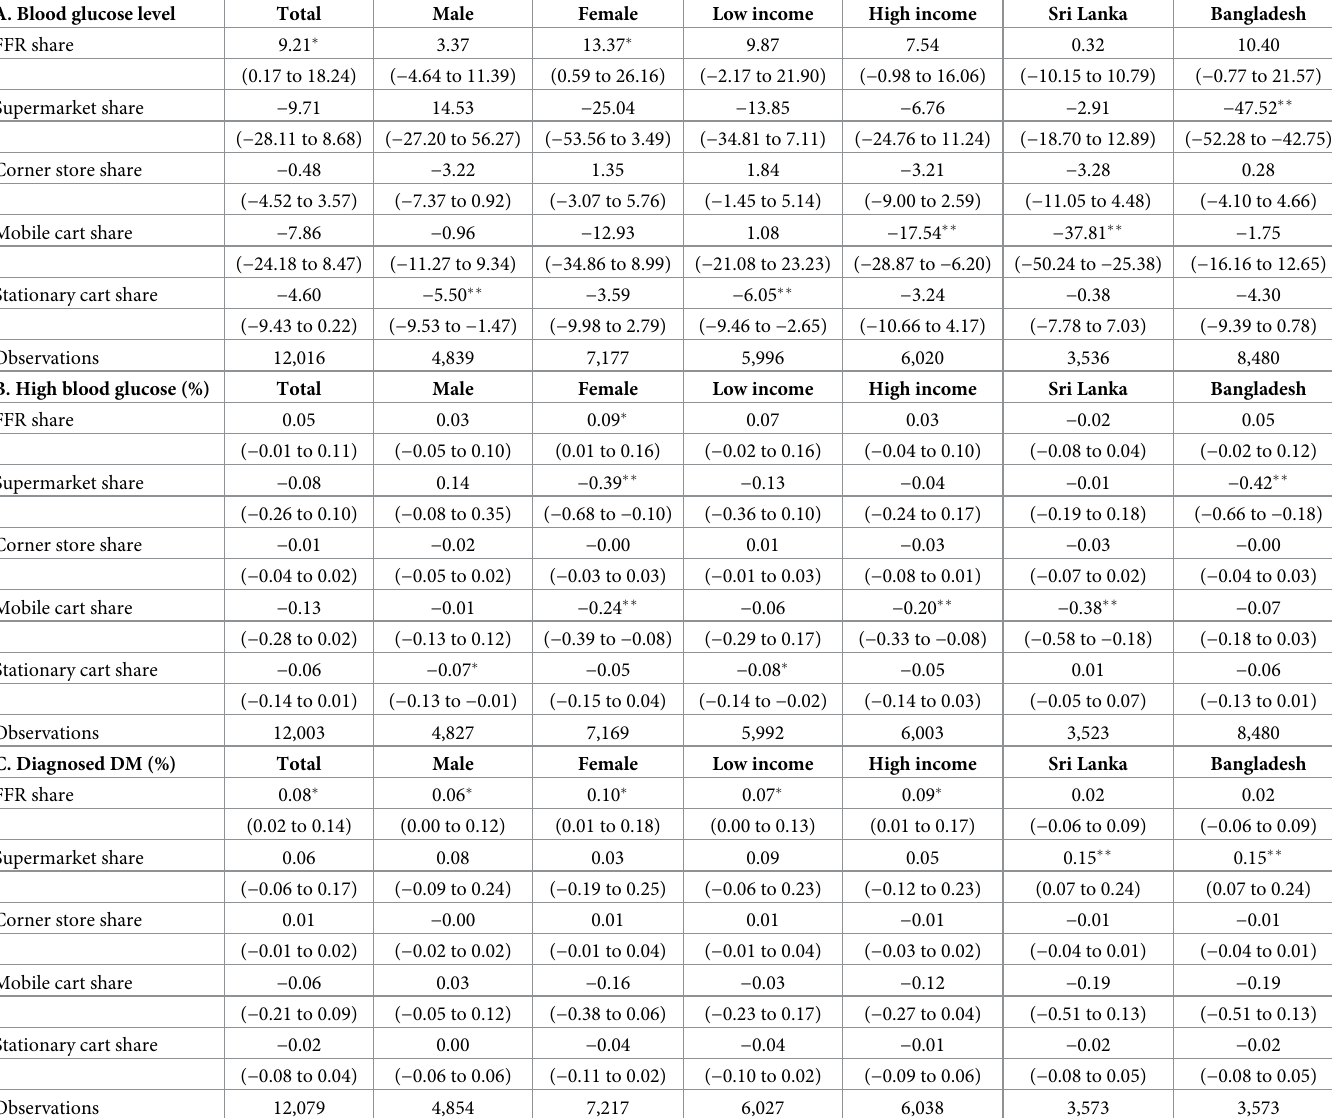
Table 2. Associations between food outlet density and fasting blood glucose (OLS coefficients), high blood glucose, and diagnosed DM (AMEs). A. Blood glucose